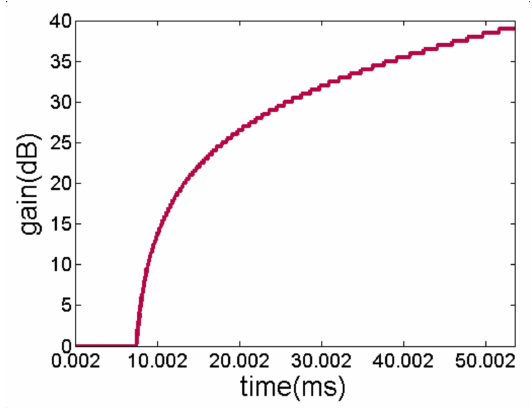
Figure 9. TVG configuration curve.